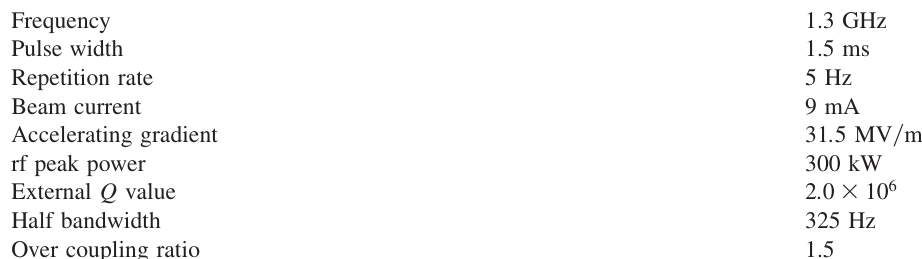
TABLE II. Main specifications of input couplers.